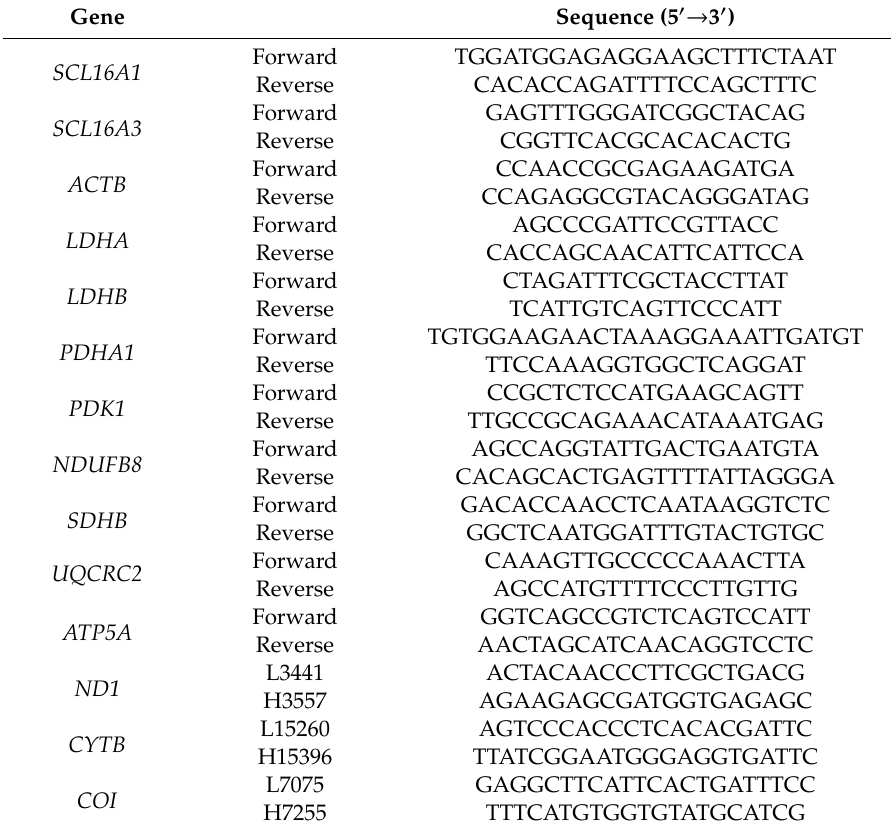
Table 2. Oligonucleotide primers used for real-time quantitative RT-PCR.